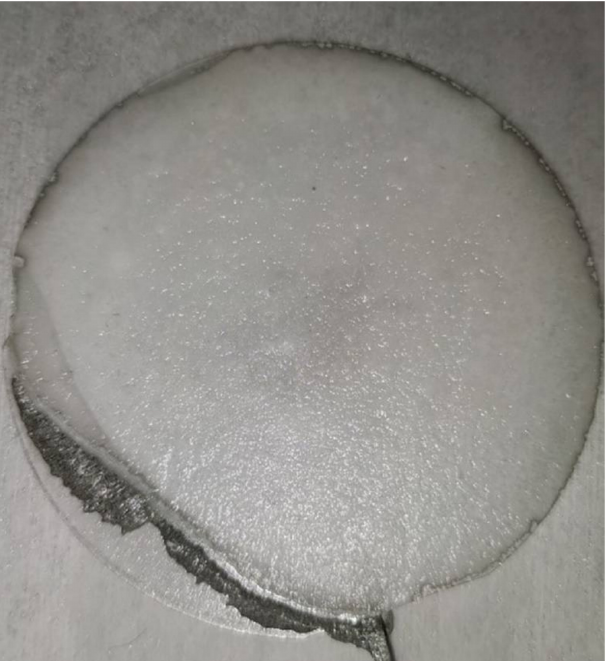
Figure 2. A picture of AlN nanowires on the